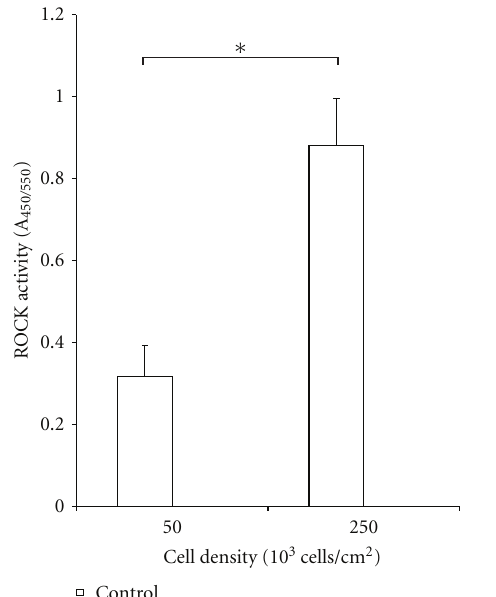
Figure 2: ROCK activities of SW620 cells seeded at 50 × 10 3 and 250 × 10 3 cells/cm 2 and allowed to invade into 1.5 mg/mL collagen sca ff olds. Cells seeded at the higher density had over double the ROCK activity compared to those seeded at the lower density. The number of cells was kept constant between the two conditions while the seeding area was altered.